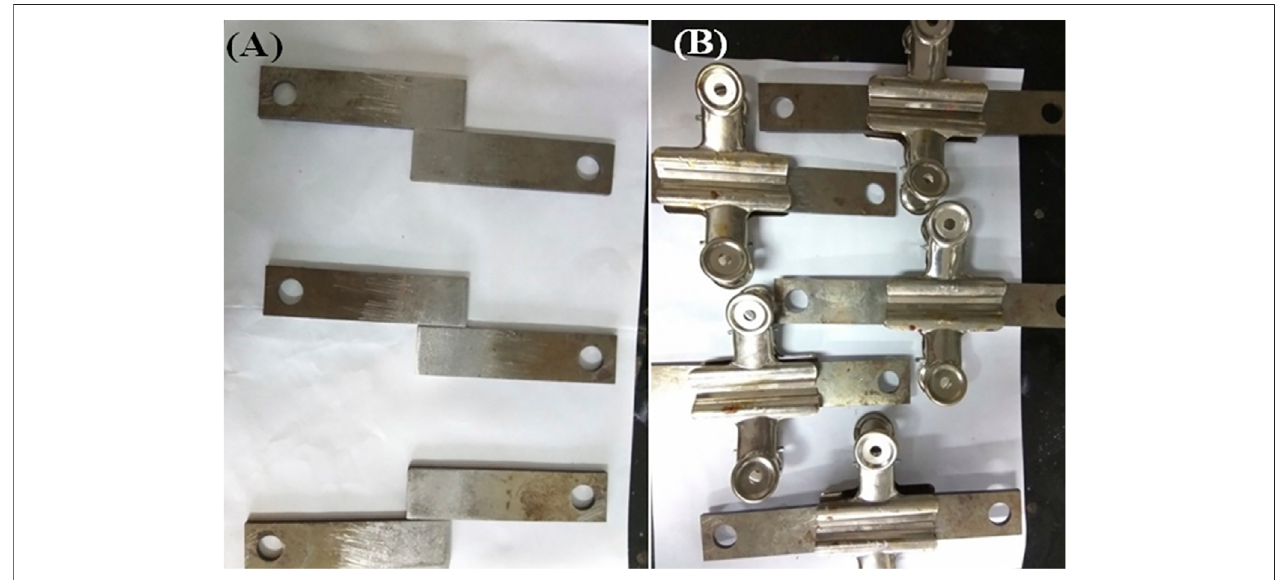
FIGURE 3 | Pictorial representation of (A) Polish steel plates of 1.3 cm length and 1.5 cm width and (B) steel plates with epoxy and CNCs.